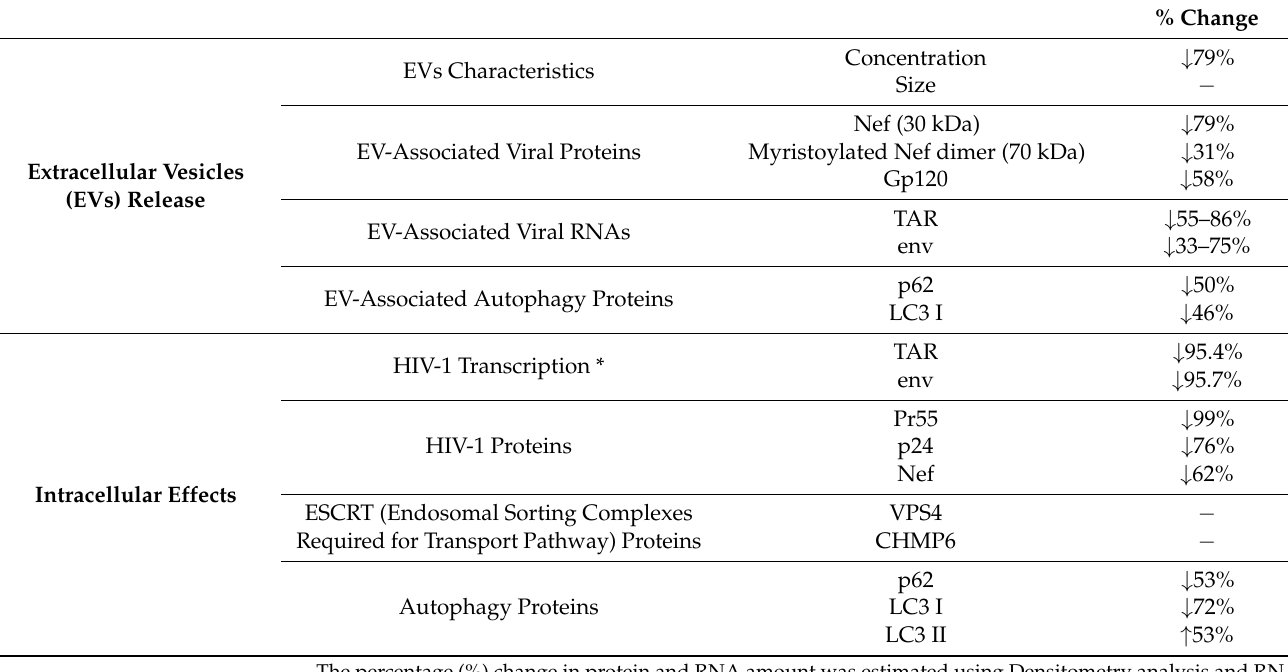
Table 1. (Summary) Effect of cannabidiol (CBD) on HIV-1 infected cells and released EVs.